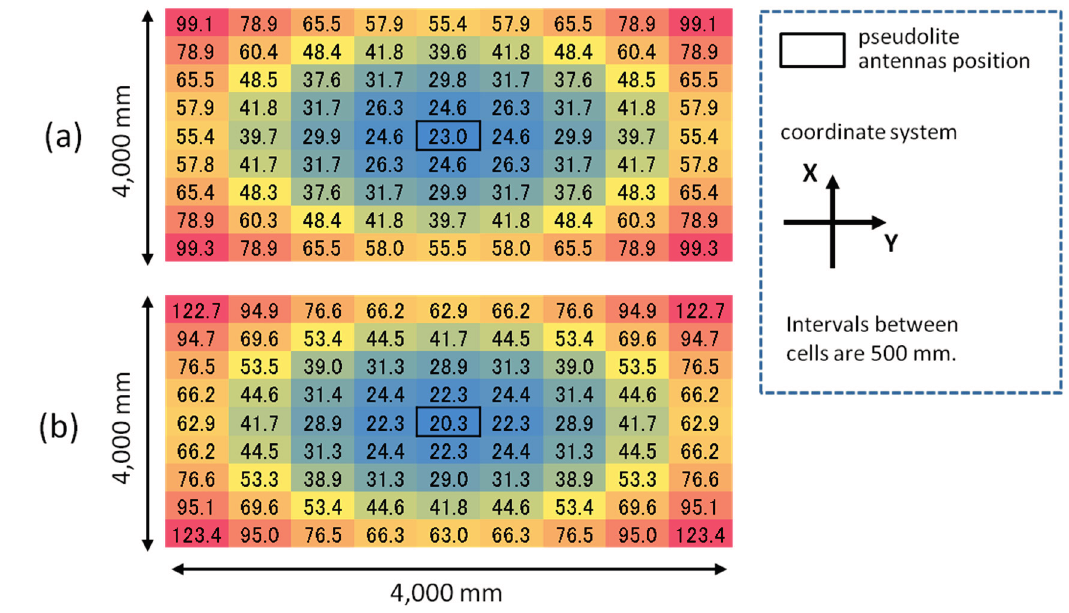
Figure 7. HDOP distributions (top views): ( a ) meeting room and ( b )